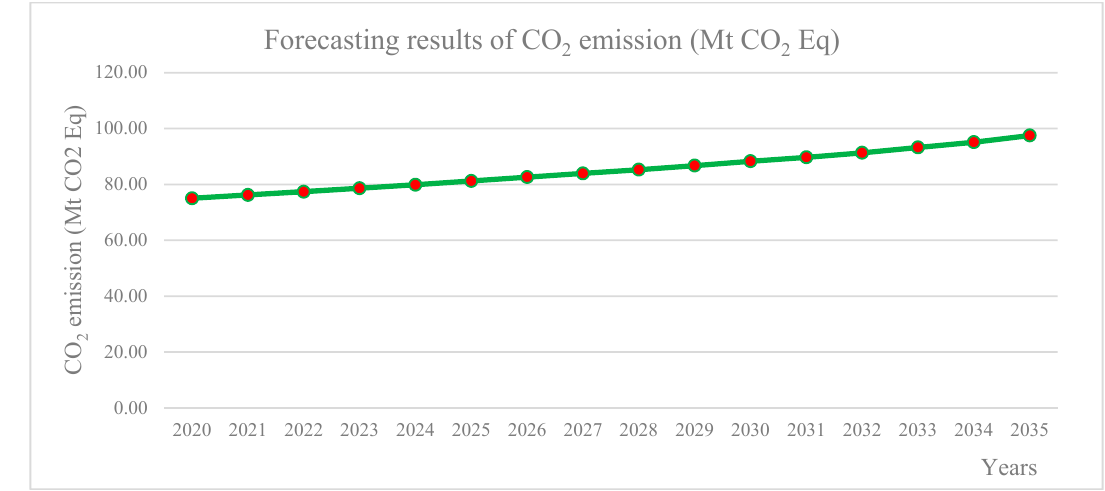
Figure 8. The forecasting results for CO 2 emission from 2020 to 2035 in Thailand .